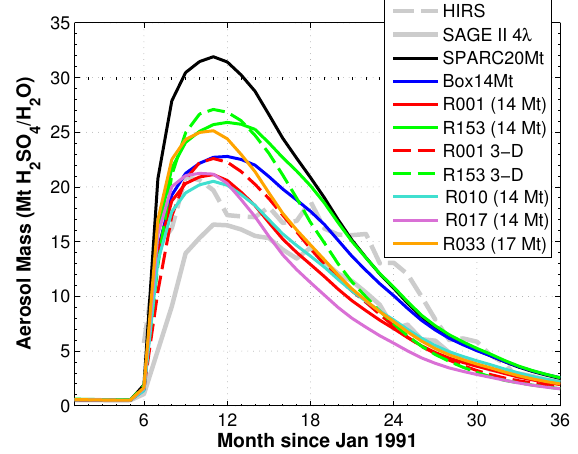
Figure 4. Cumulative particle number concentrations of OPC mea- surements (Deshler et al., 2003; Deshler, 2008), and model simula- tions in October 1991 (upper panels) and December 1991 (lower panels) for particle size channels r > 0 . 15µm (left panels) and r > 0 . 5µm (right